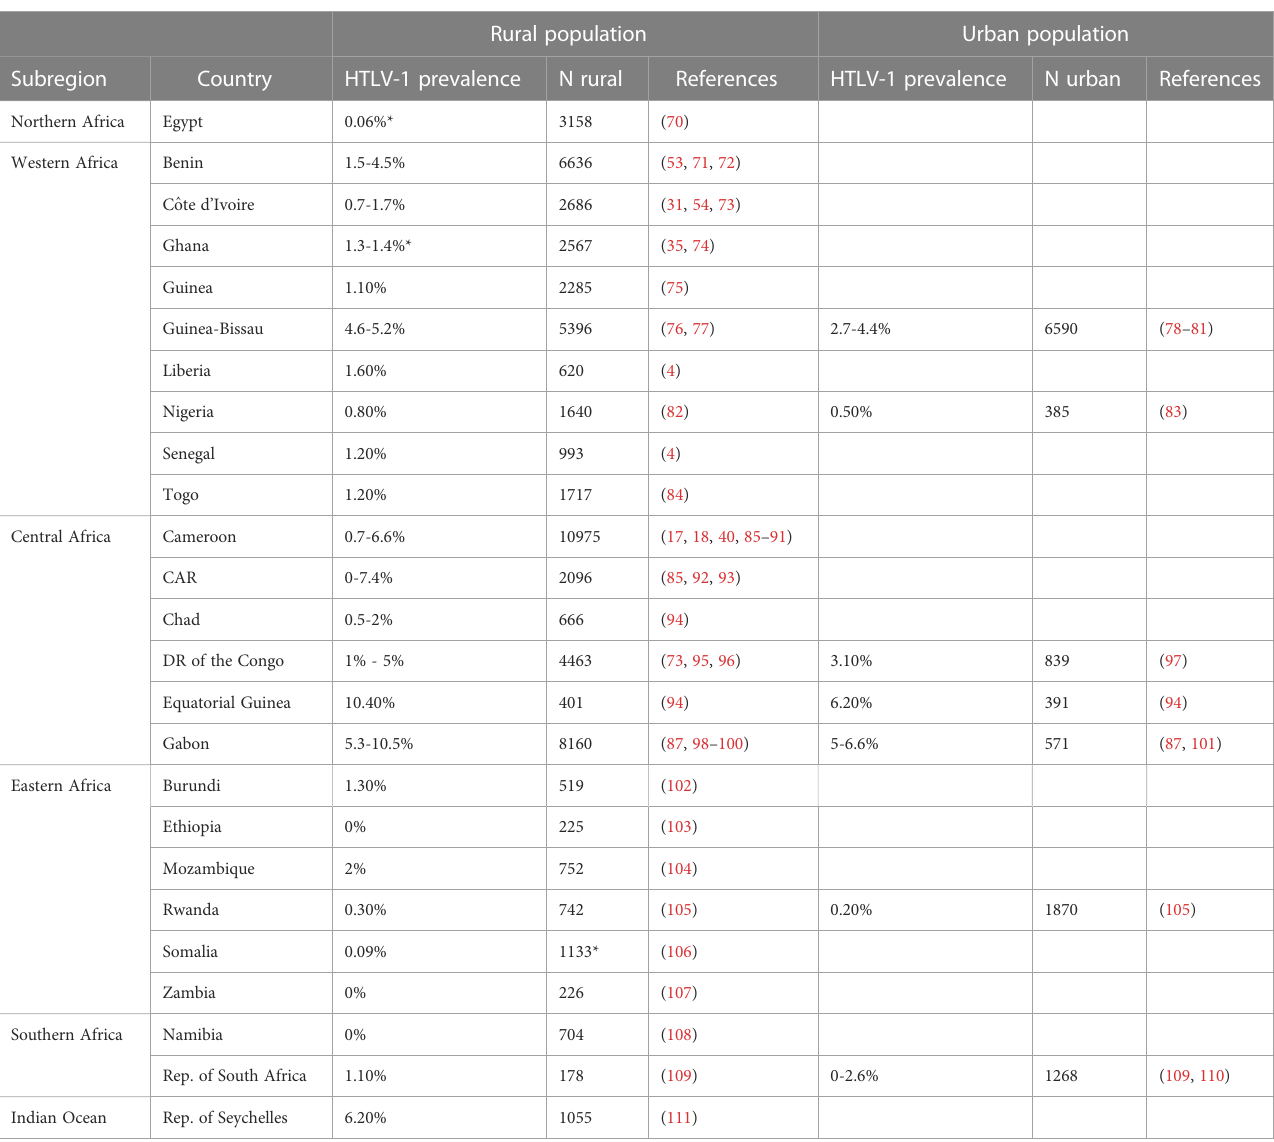
TABLE 3 HTLV-1 prevalence among African rural and urban adult